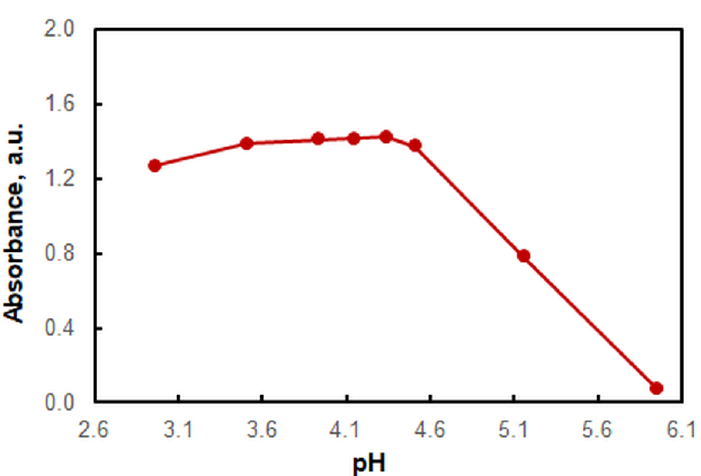
Figure 3. Effect of pH on the absorbance of the chloroform extract; 3 × 10 −5 mol L −1 of V(V), 3 × 10 −4 mol L −1 of HTAR, 1 × 10 −4 mol L −1 of HZH, extraction time of 45 s, λ = 554 nm.